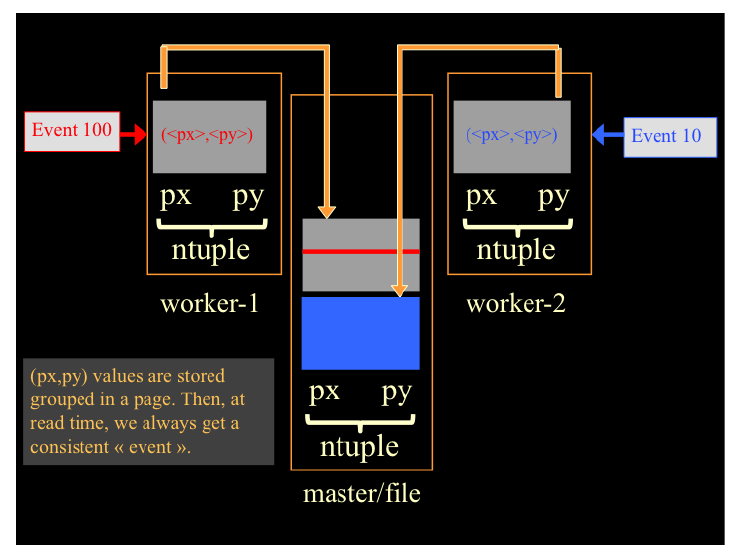
Figure 2. gopaw on the B4 HDF5 file